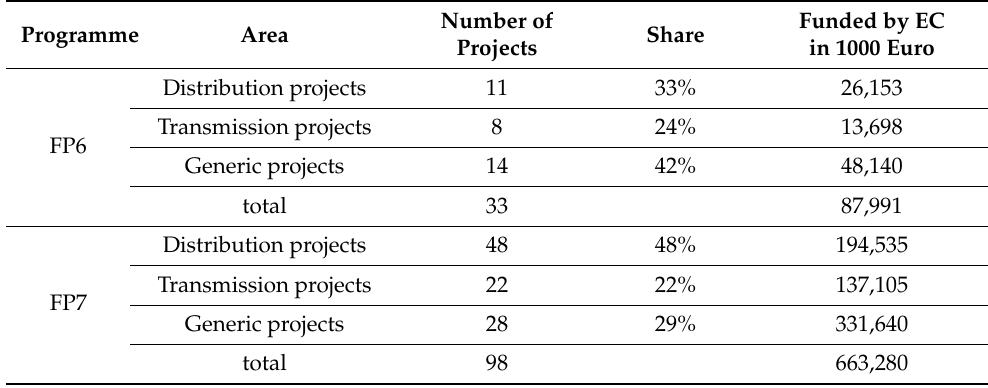
Table 6. The number of projects (N = 244) in the three different areas and their funding.